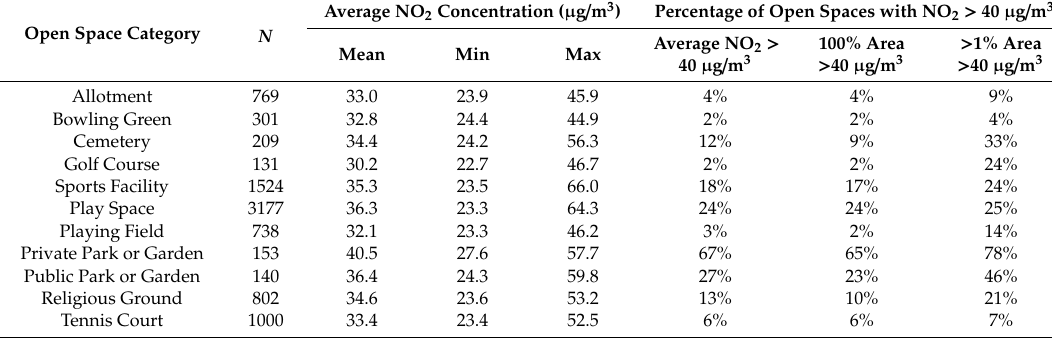
Table 1. Average nitrogen dioxide (NO 2 ) concentrations in open spaces by category, including the percentage of open spaces above the legal limit of 40 µ g / m 3